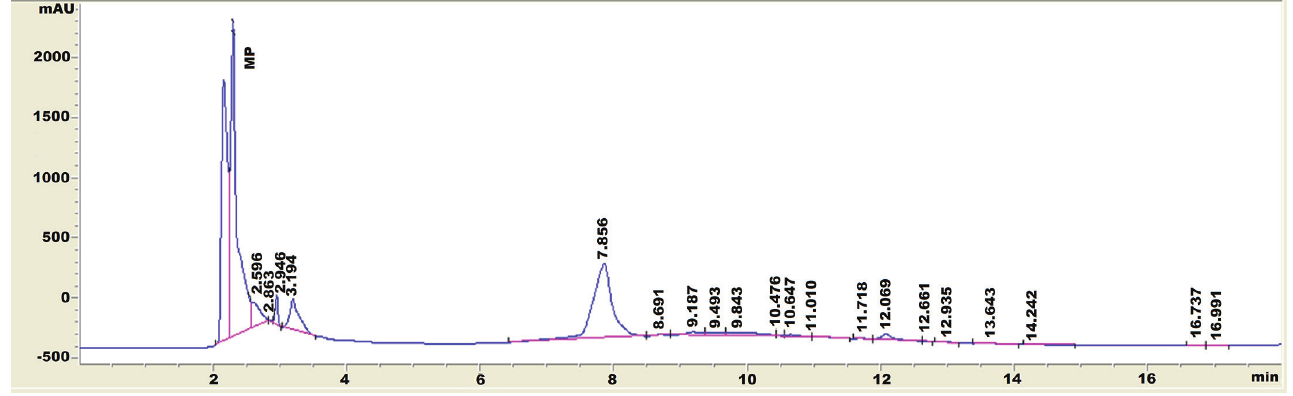
FIGURE 1 - Enlarged HPLC chromatogram of methanolic fraction obtained from Lepista sordida